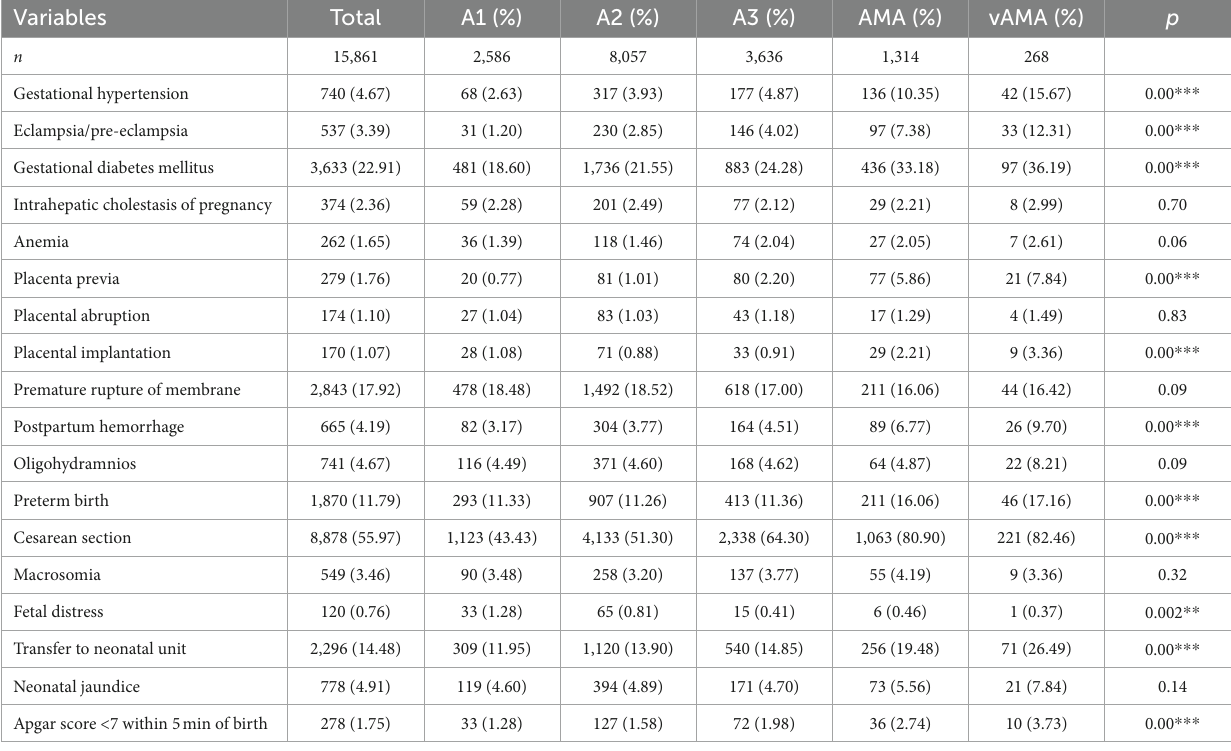
Table 5 and Figure 3. The 20–24-year-old nulliparous women were